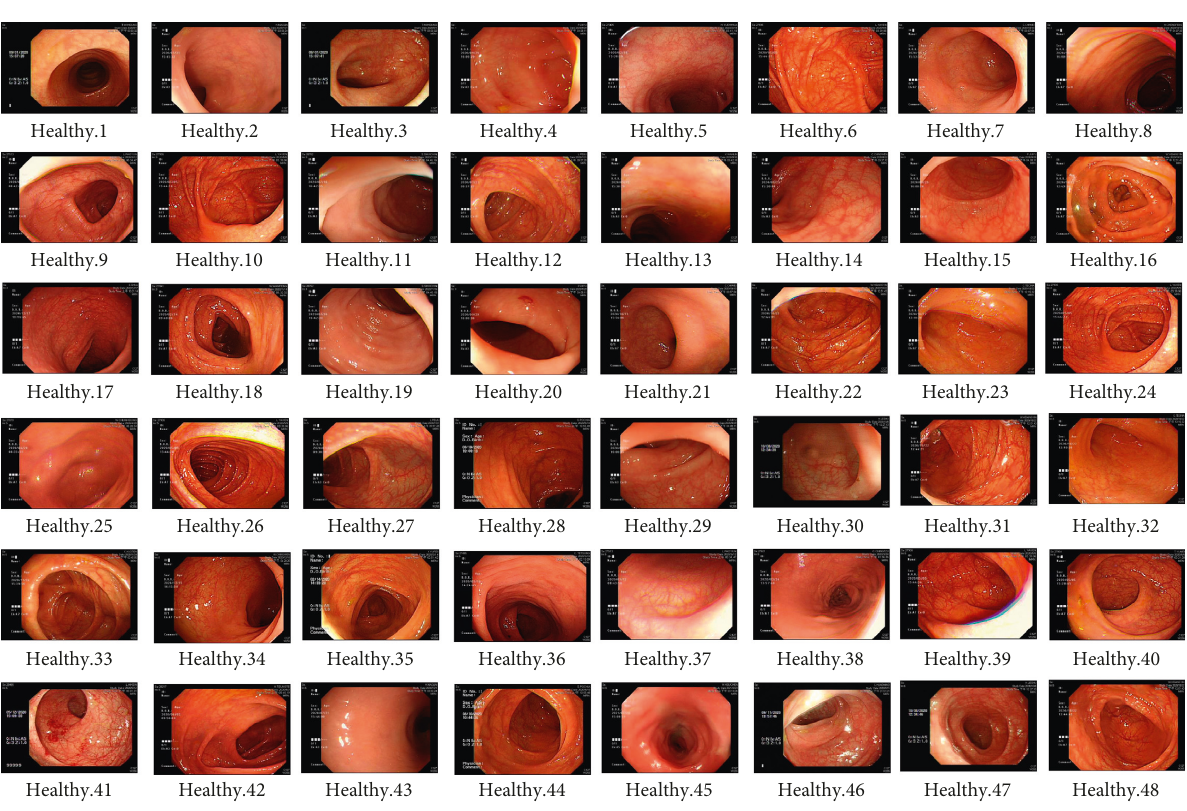
Figure 1: Healthy